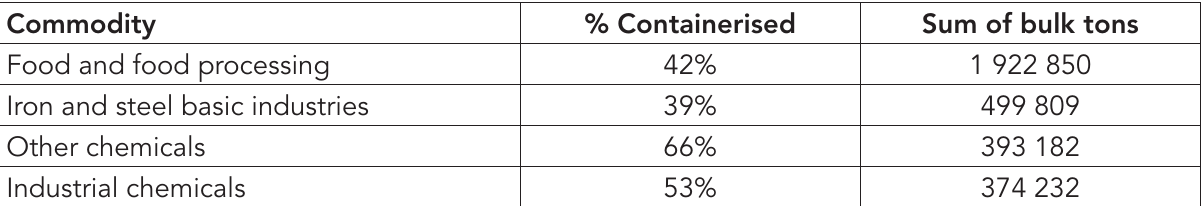
Table 3: Commodity groups, percentage containerised and bulk tons for imports (2009)